Question: What does this figure show? Answer in one sentence.
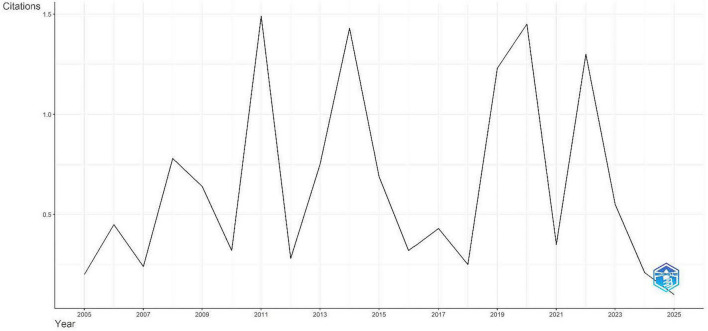
Answer: Average citations per article per year. Trend of average citation impact per year across the study period, illustrating fluctuations in scholarly influence over time.